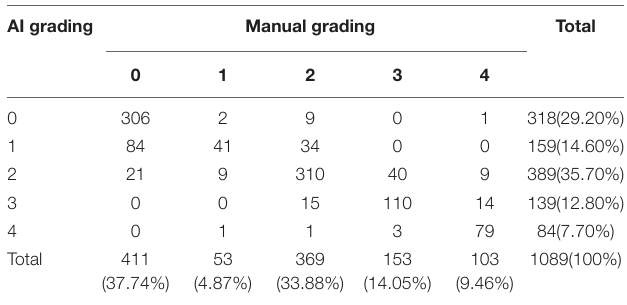
TABLE 1 | Distribution of manual grading and AI software grading for